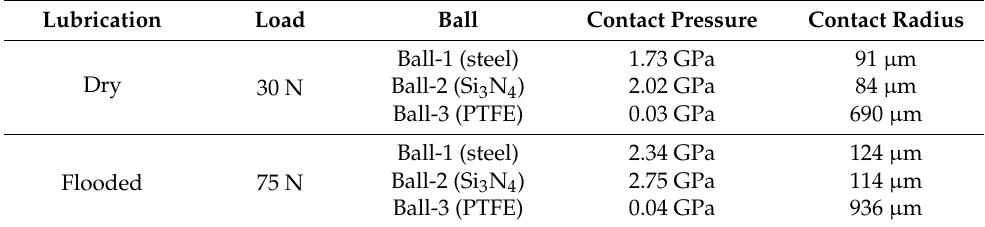
Table 5. Contact